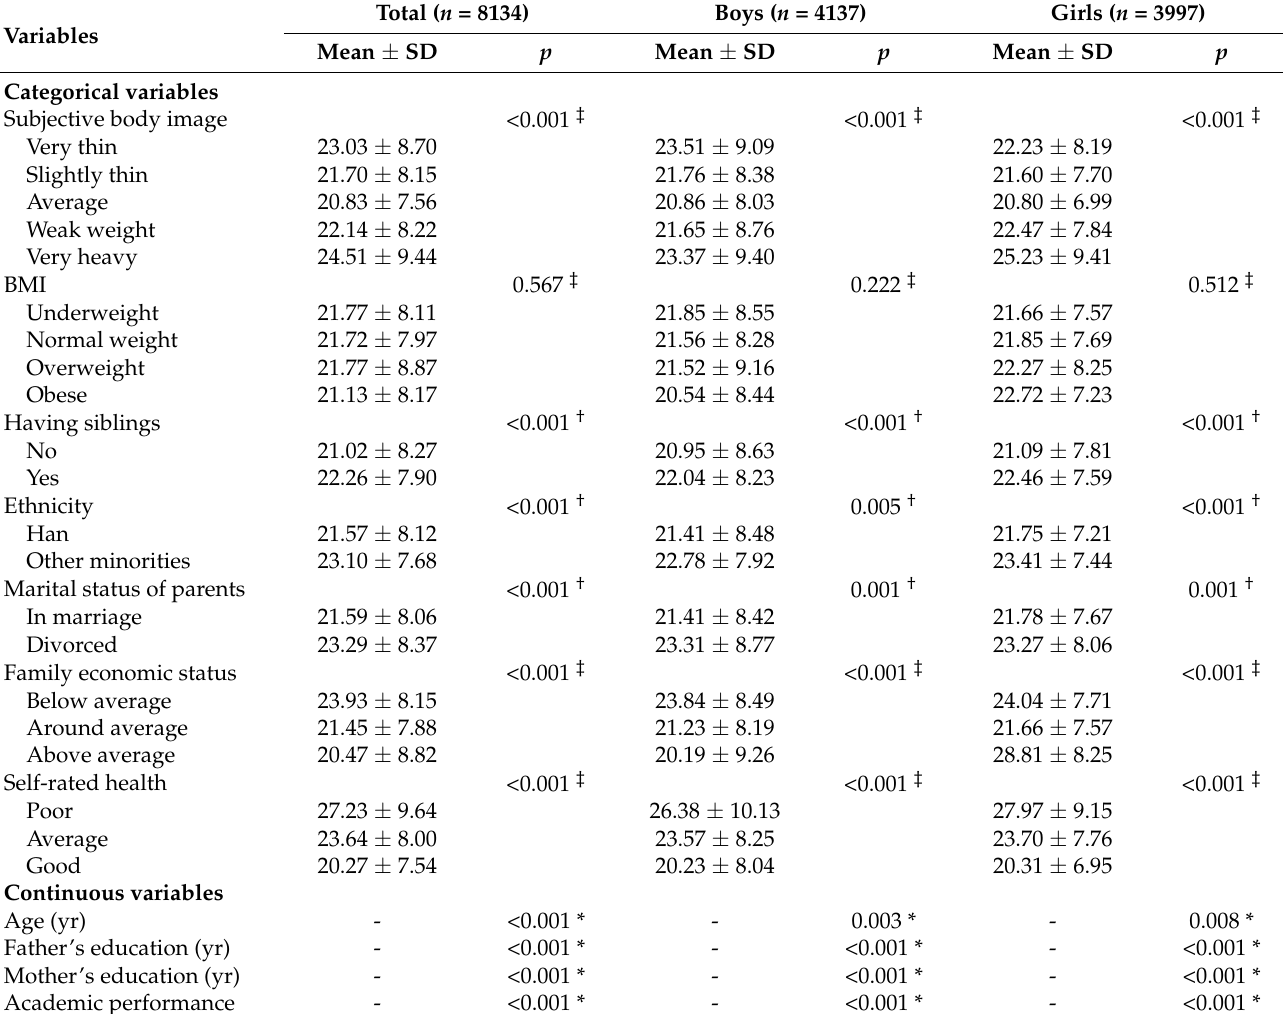
Table 2. Bivariate analysis between BMI, SBI, independent variables and psychological